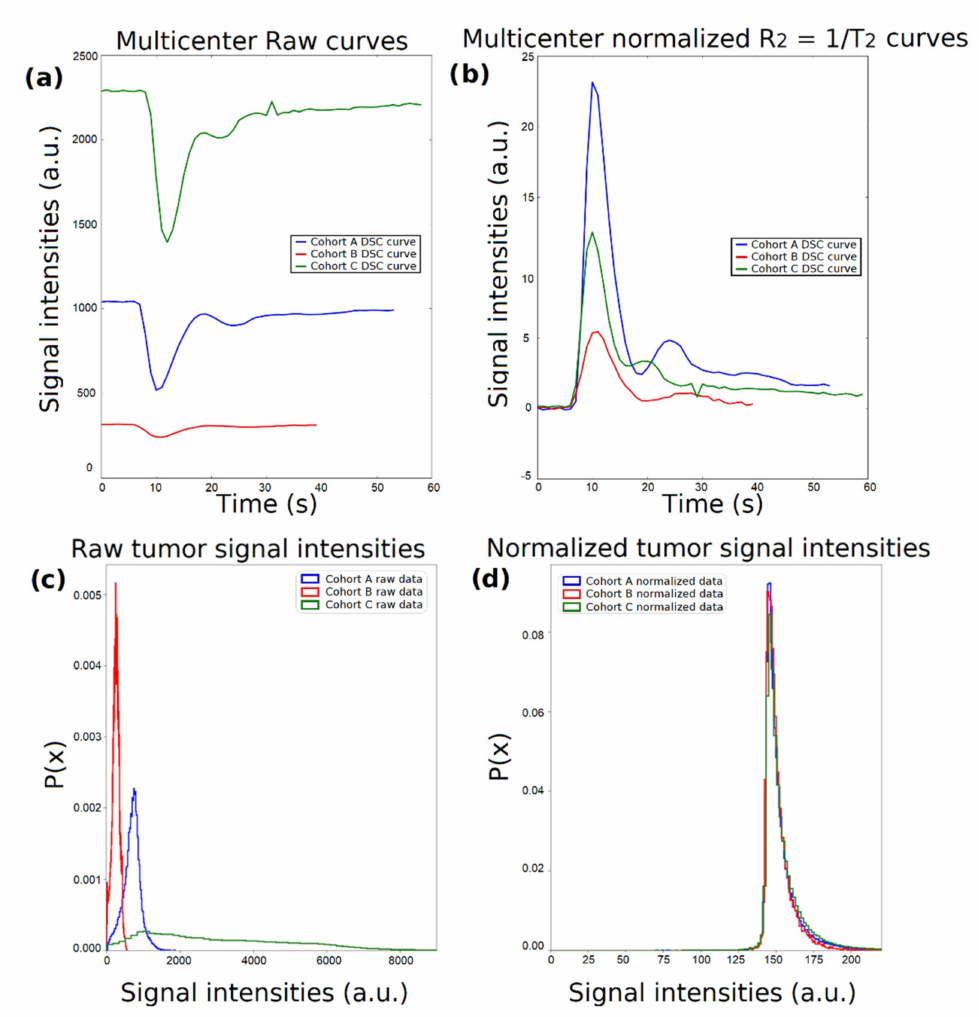
Figure 2. Schematic representation of the normalization process. ( a ) Dynamic susceptibility contrast (DSC) perfusion curves from the 3 tertiary centers. ( b ) ∆ R 2 ( t ) curves after normalization using equation (1). ( c ) Center-specific probability density functions of the raw signal intensities within the voxels of interest (VOIs) at time point T_max. ( d ) Center-specific probability density functions of the normalized signal intensities within the VOIs at time point